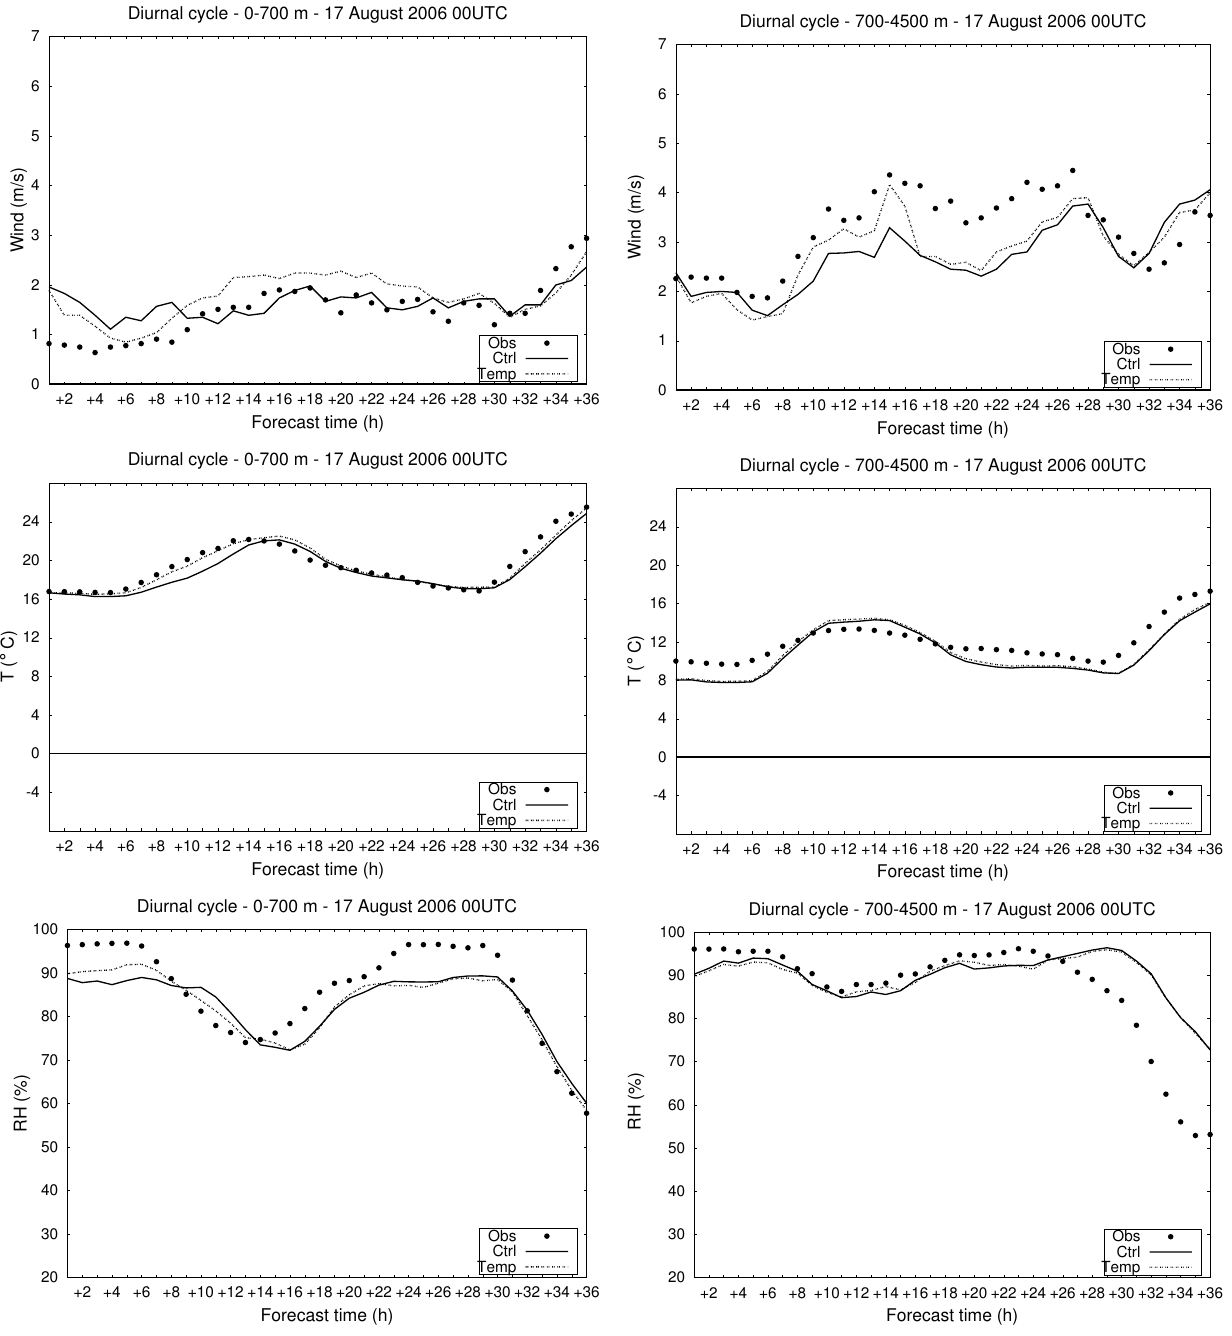
Fig. 6. Diurnal cycle for the August 2006 case, over the plains (left) and over the mountains (right); wind intensity (upper panels), temperature (middle panels) and relative humidity (bottom panels). The dots represent the Ctrl run and the dotted line represents the Temp run.